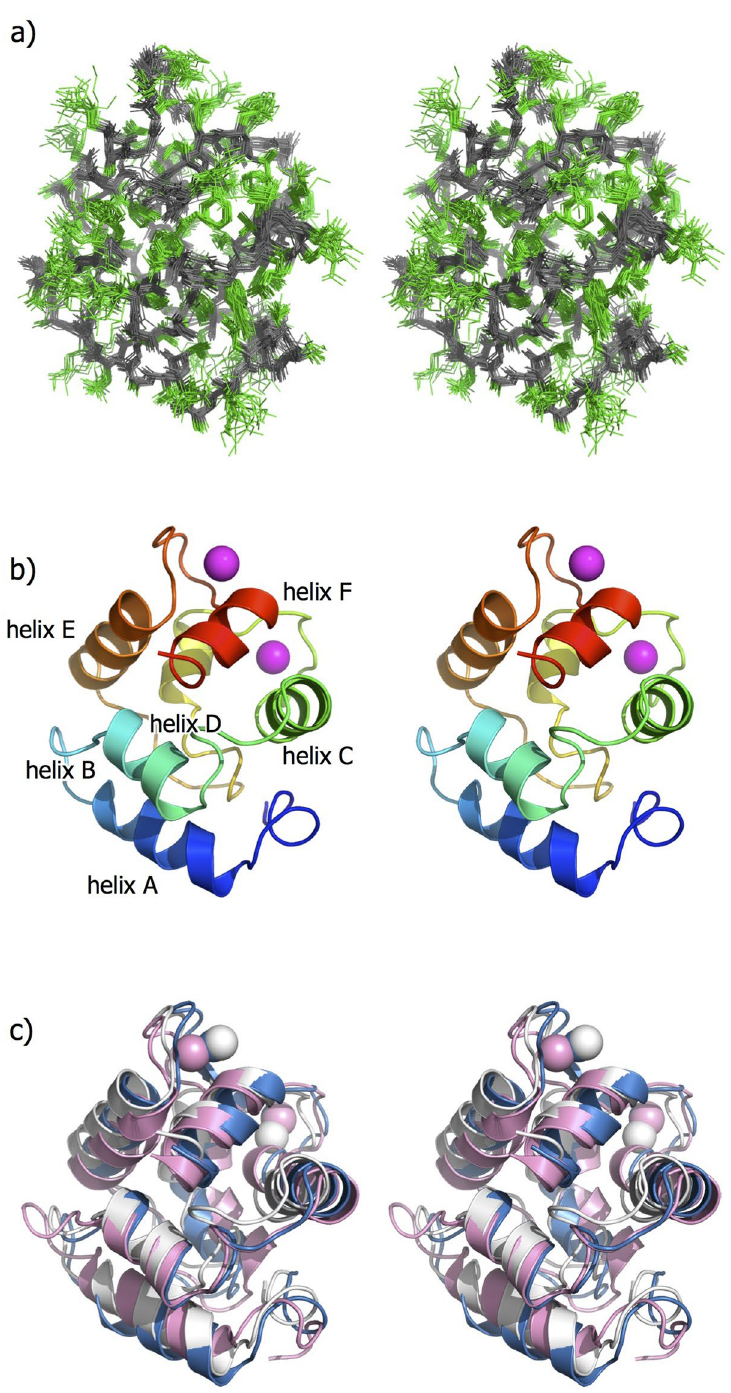
Figure 2. NMR structures of the Pacific mackerel parvalbumin Sco j 1 in stereo. ( a ) Overlay of the ensemble of 20 final energy-minimized CYANA structures. The main and side chains are colored in gray and green, respectively. ( b ) Ribbon diagrams of the lowest energy structure. Two Ca 2 + ions are shown as magenta balls. ( c ) Superposition of fish allergenic parvalbumin structures of Sco j 1 (white), Cyp c 1 (cyan), and Gad m 1 (pink). All the figures were drawn using PyMOL